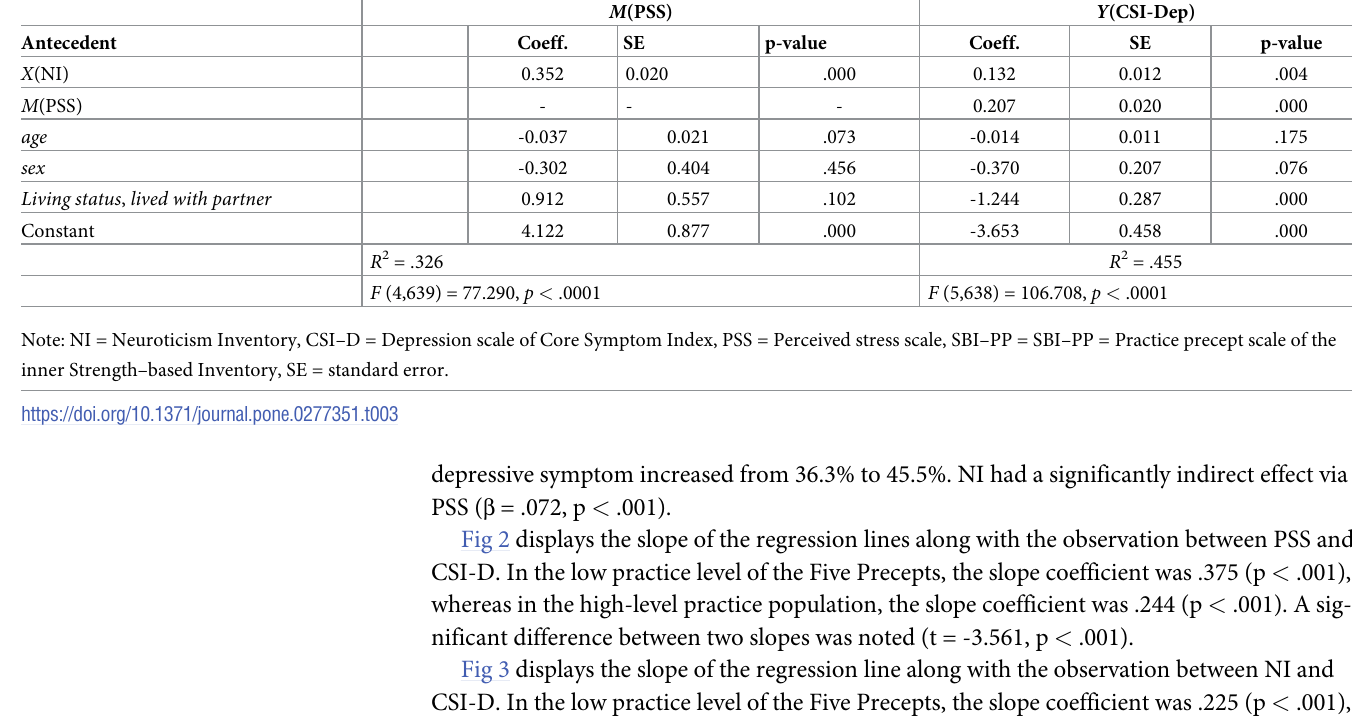
Table 3. Summary of mediation analysis of neuroticism and perceived stress predicting depressive symptoms controlling for age, sex, and living status. M (PSS)